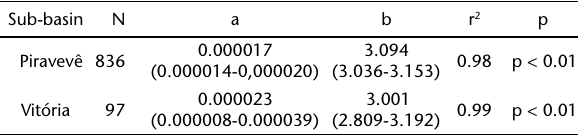
Table II. Non-linear regression analysis of weight in function of standard length (SL) of individuals as the estimated values of “a” and “b”, as well as the confidence interval, for the streams of the Ivinhema River basin, from January to December 2002. Sub-basin